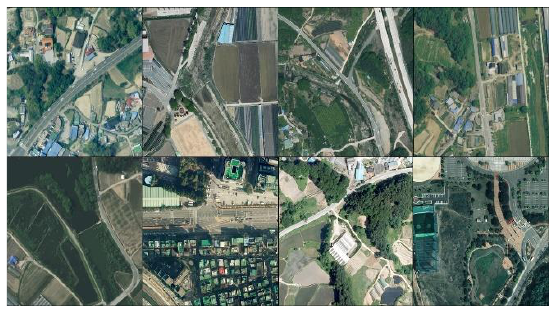
Figure 1. Samples of GCP Chips used for experiments.